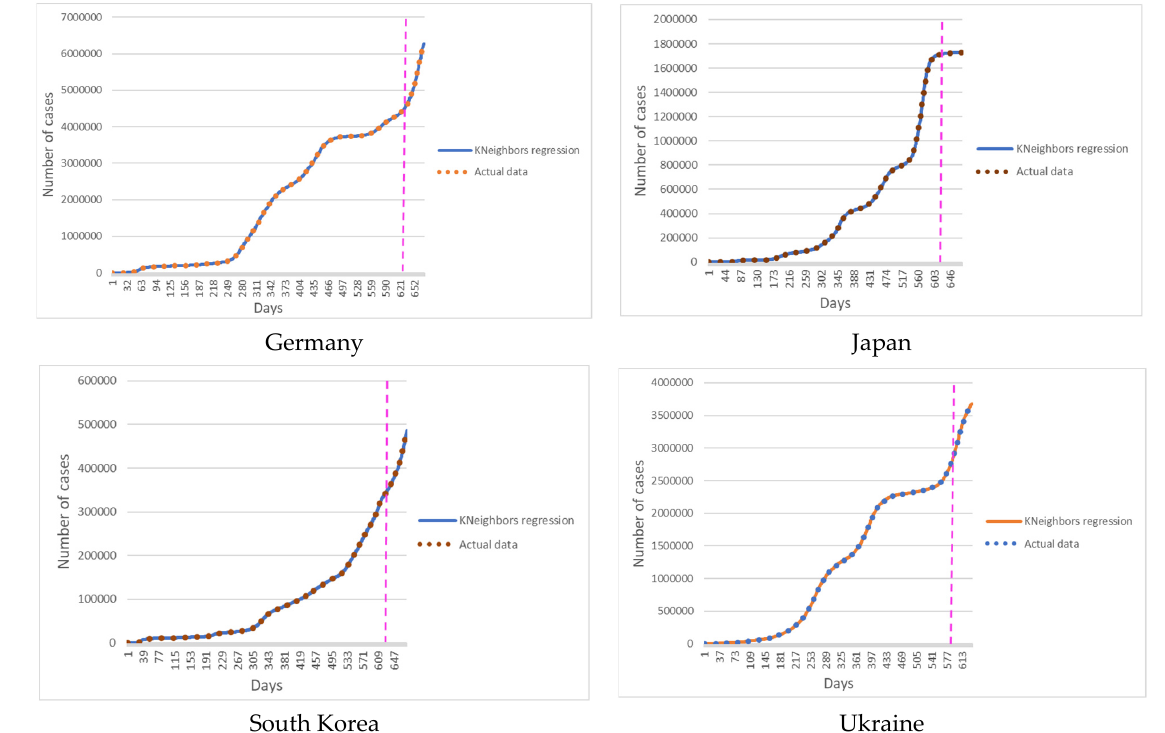
Figure 2. Forecasting of COVID-19 new cases by K-Nearest Neighbors model.